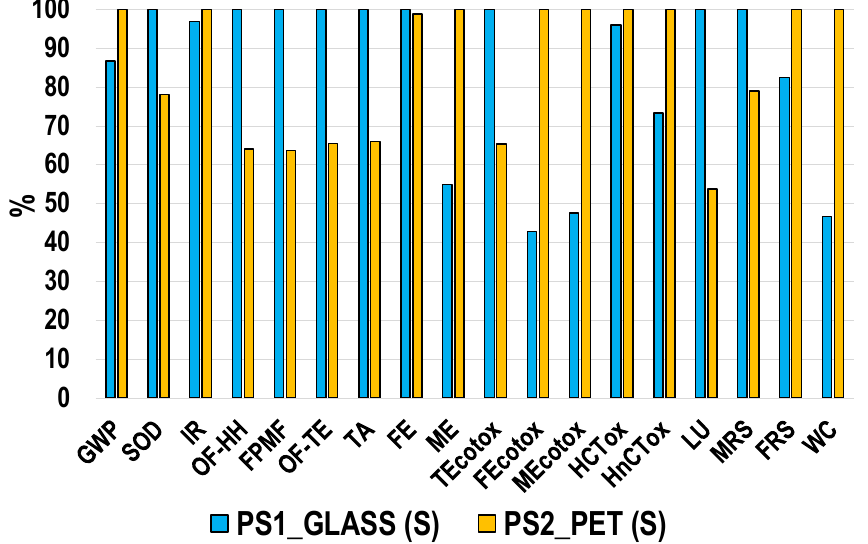
Figure 3. Comparison between the life cycle impacts of the considered packaging systems (PS1_GLASS and PS2_PET) for the sparkling drinking (S) water.